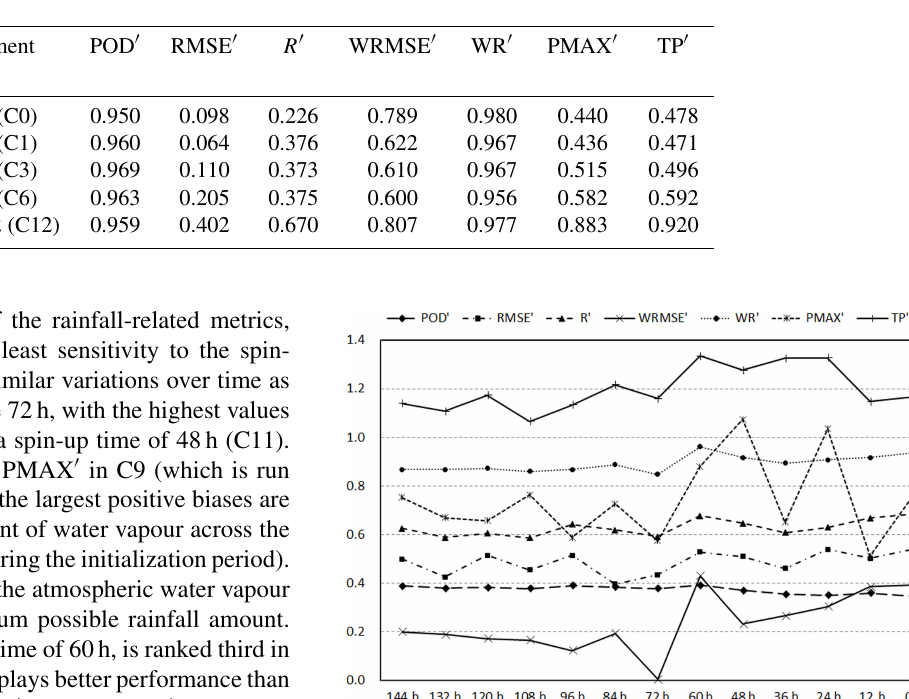
Figure 8. As in Fig. 7, but the metrics are calculated over 18h peri- ods and over domain two in Case